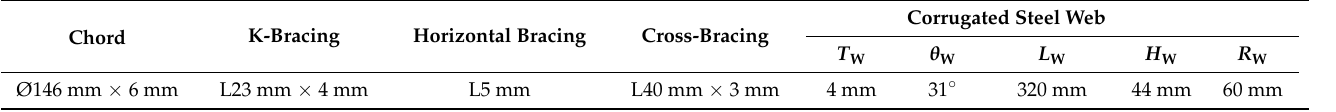
Table 1. Summary of test model